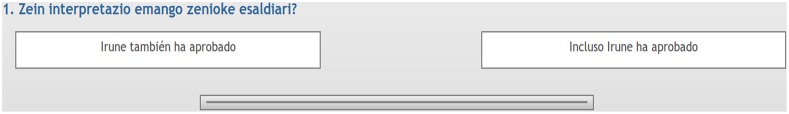
Visual analogue scale with unambiguous Spanish sentences at both ends (non-scalar simple additive también “also” on the left, Irune también ha aprobado “Irune also passed it”; scalar additive incluso “even” on the right, Includo Irune ha aprobado “Even Irune passed it”).